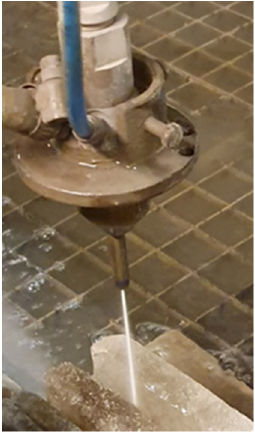
Figure 3. Water nozzle (STM Stein-Moser GmbH) during the salt rock cutting test.